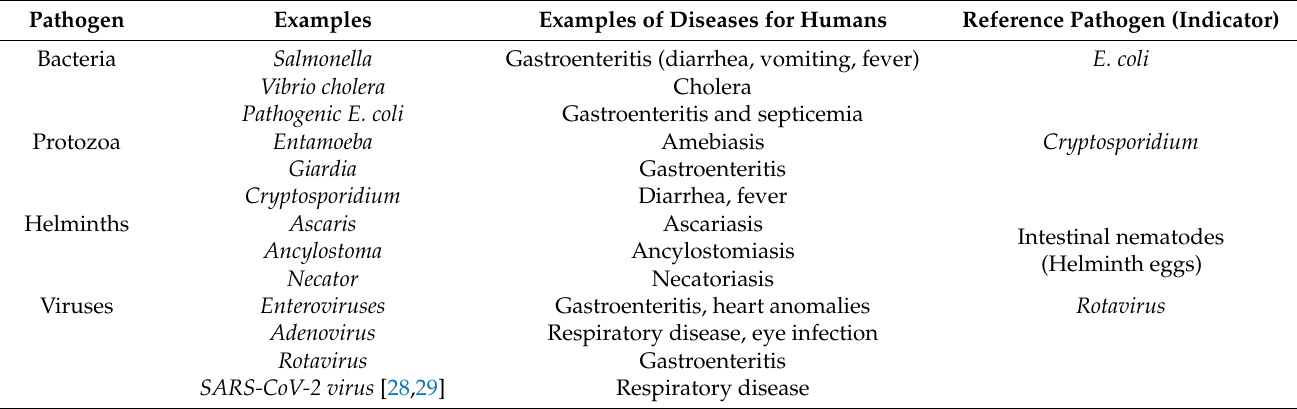
Table 4. Microorganisms present in wastewater and their effects on human health